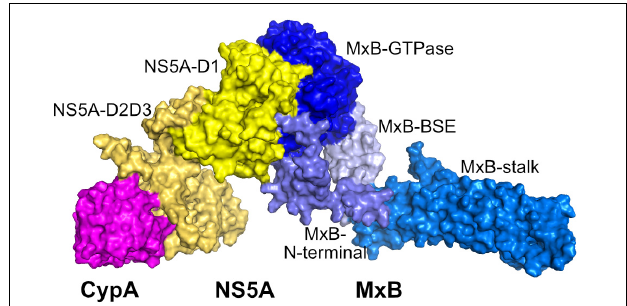
FIGURE 6 | Predicted ternary CyPA–NS5A–MxB complex structure. CyPA, NS5A, and MxB are shown in magenta, yellow, and blue surface, respectively. CypA, cyclophilin A; NS5A, non-structural protein 5A; MxB, myxovirus resistance